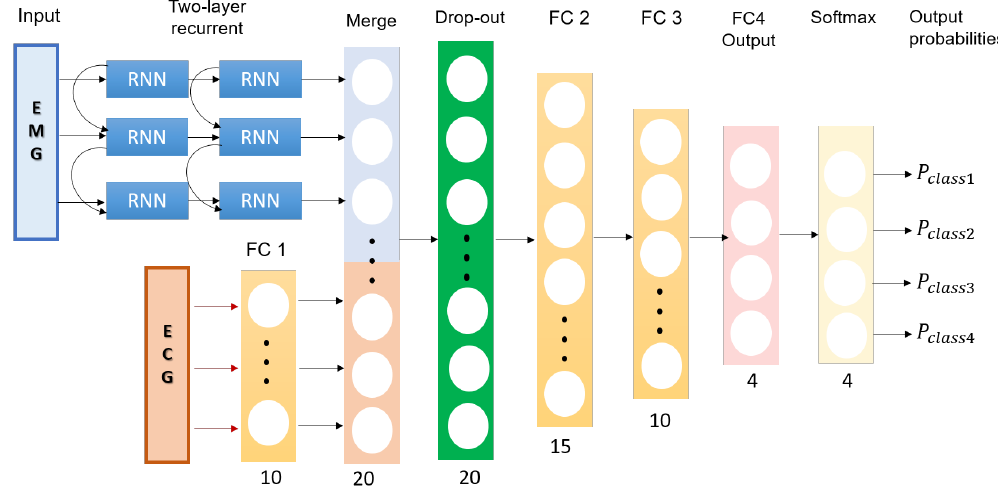
Figure 3. Architecture schema of the proposed multimodal EMG-ECG